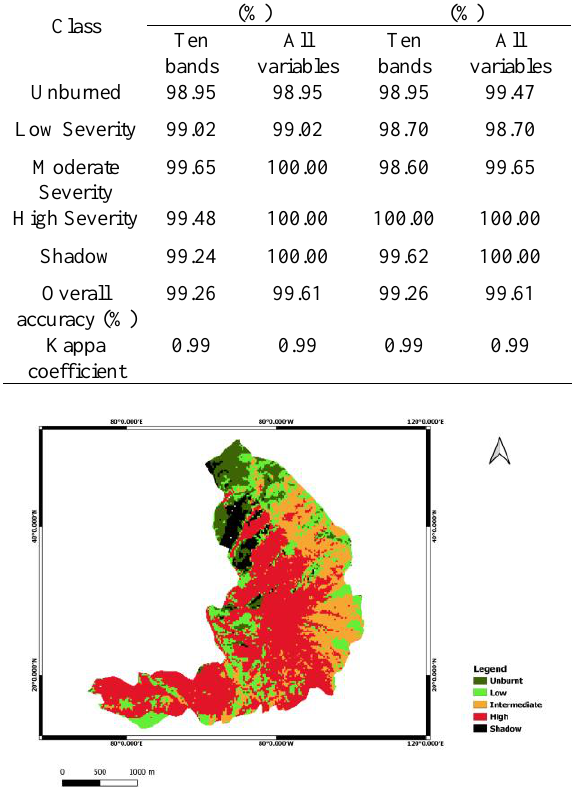
Figure 4 . Classified image produced by applying the Random Forest classifier to the original post-fire band images, associated vegetation indices, DEM, and slope data.